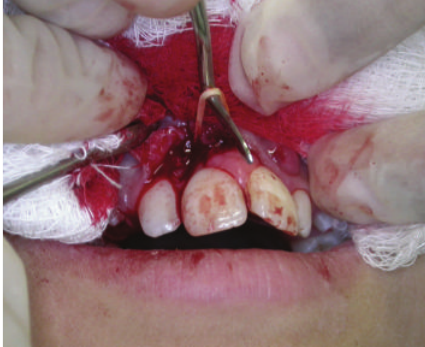
Figure 3: Transoperative clinical findings.